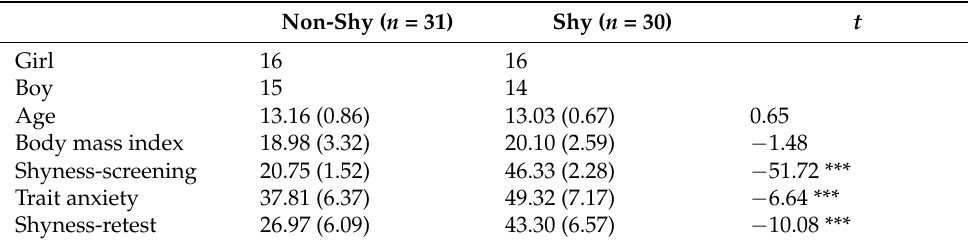
Table 1. Demographic characteristics of the sample: Means (with standard deviations), and t -test statistics for group comparisons.